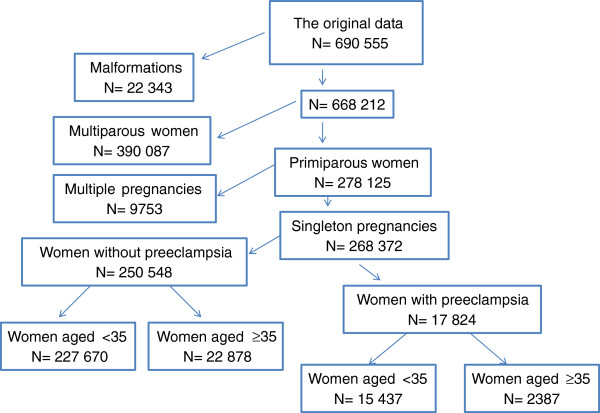
The data flow in the current study222223232323.